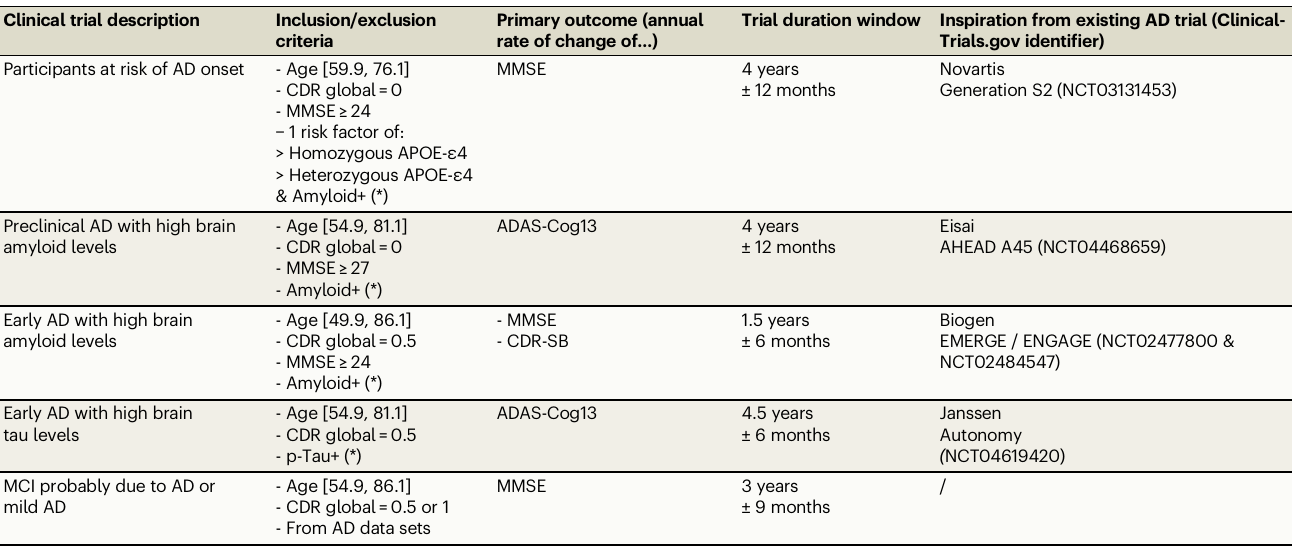
Table 3 | Description of the simulated trials Clinical trial